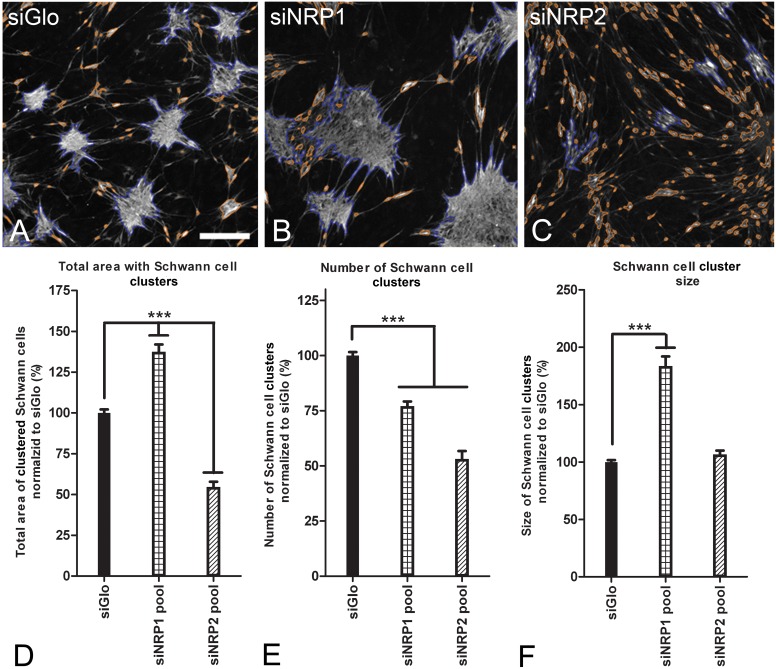
Knockdown of NRP1 increases while knockdown of NRP2 decreases formation of Schwann cell clusters.(A–C) Representative SC clusters when co-cultured with MCs for 5 days after a transfection with siGlo, siNRP1 pool or siNRP2 pool respectively. SCs are shown in grey (S100 labeling). MCs are not labeled. Valid cell clusters were outlined with a blue line. Invalid clusters were outlined with an orange line. Scalebar = 250 µm. (D) The total area of SC clusters per well after knockdown of NRP1 or NRP2. There was a significant increase in total area of SC clusters after knockdown of NRP1 (137%) while in contrast, there was a strong decrease of total area of SC clusters after knockdown of NRP2 (54%). (E) The number of valid clusters per well significantly decreases to 77% after knockdown of NRP1 and 53% after knockdown of NRP2. (F) Cluster size after knockdown of NRP1 increases strongly to 183% (p<0.001) when compared to the siGlo condition, while the average SC cluster size after knockdown of NRP2 does not change. Values are normalized to the siGlo condition and represent the averages of all wells of 6 separate experiments. Error bars indicate the SEM.